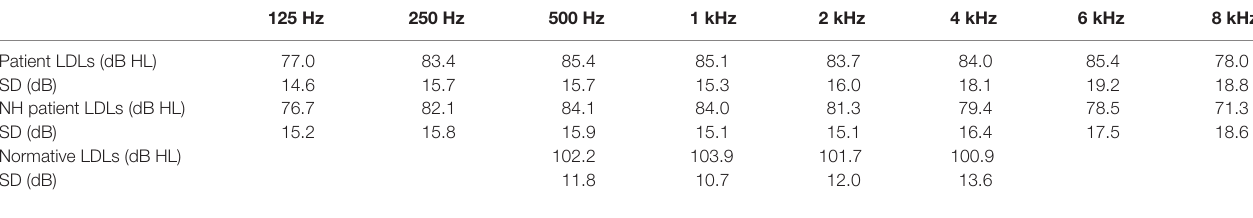
TaBle 1 | average lDls of all patients, of the subgroup of patients with normal hearing thresholds, and normative estimates for lDls from a study by sherlock and Formby (12). 125 hz 250 hz 500 hz 1 khz 2 khz 4 khz 6 khz 8 khz Patient LDLs (dB